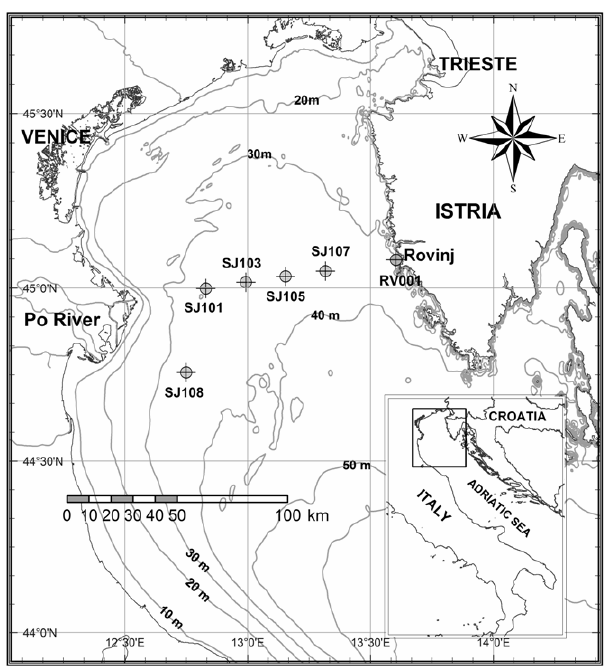
Figure 1. Map of the NA with sampling